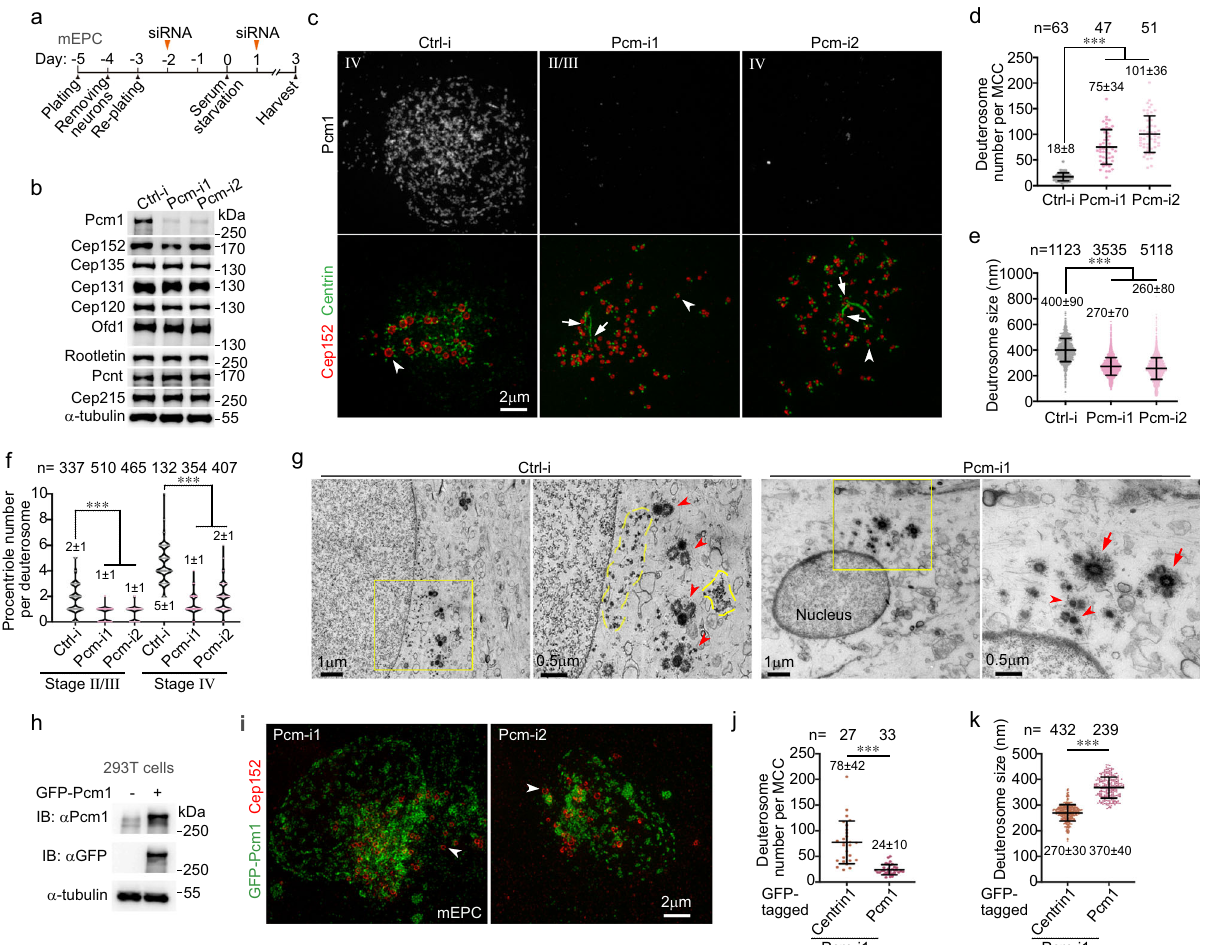
Fig. 2 Depletion of Pcm1 abolishes FGMs and affects deuterosome growth and number. Arrows and arrowheads respectively indicate parental centrioles and representative deuterosomes. Both sample dots and mean ± s.d. are presented in quanti fi cation results. Two-tailed Mann – Whitney U -test: *** P < 0.001. a Experimental scheme for Pcm1 RNAi. Mouse ependymal cell (mEPC) precursors were cultured from P0 mouse brain tissues at day − 5 and induced to differentiate into MCCs through serum starvation at day 0. The cells were transfected with siRNAs twice and collected at day 3 for